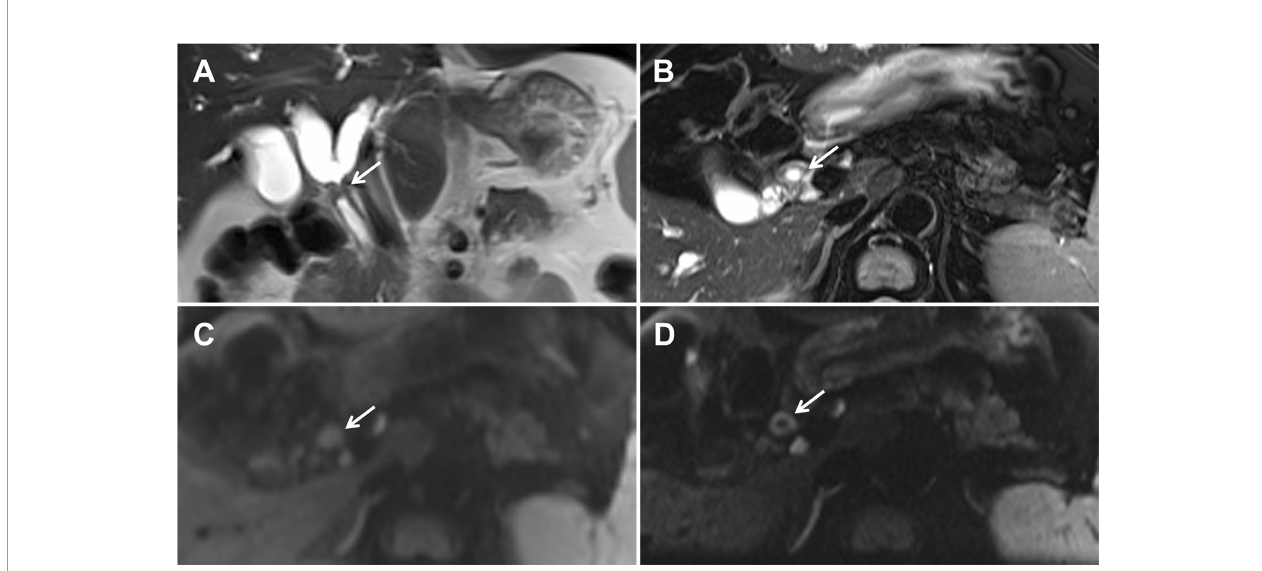
FIGURE 1 | A 52-year-old man with Bismuth-Corlette type I hilar cholangiocarcinoma. Coronal (A) and axial (B) T2-weighted magnetic resonance imaging images demonstrating the hepatic duct with wall thickening and mild hyperintensities. Conventional echo-planar (c-EPI) diffusion-weighted imaging (DWI) (C) and zoomed echo-planar imaging (z-EPI) DWI (D) was obtained at b=800 s/mm 2 . The common hepatic duct lesion showed hyperintensities. In addition, the thickened common hepatic duct wall is better delineated on the z-EPI DWI image (arrow in D ) compared with the c-EPI DWI image (arrow in C ).